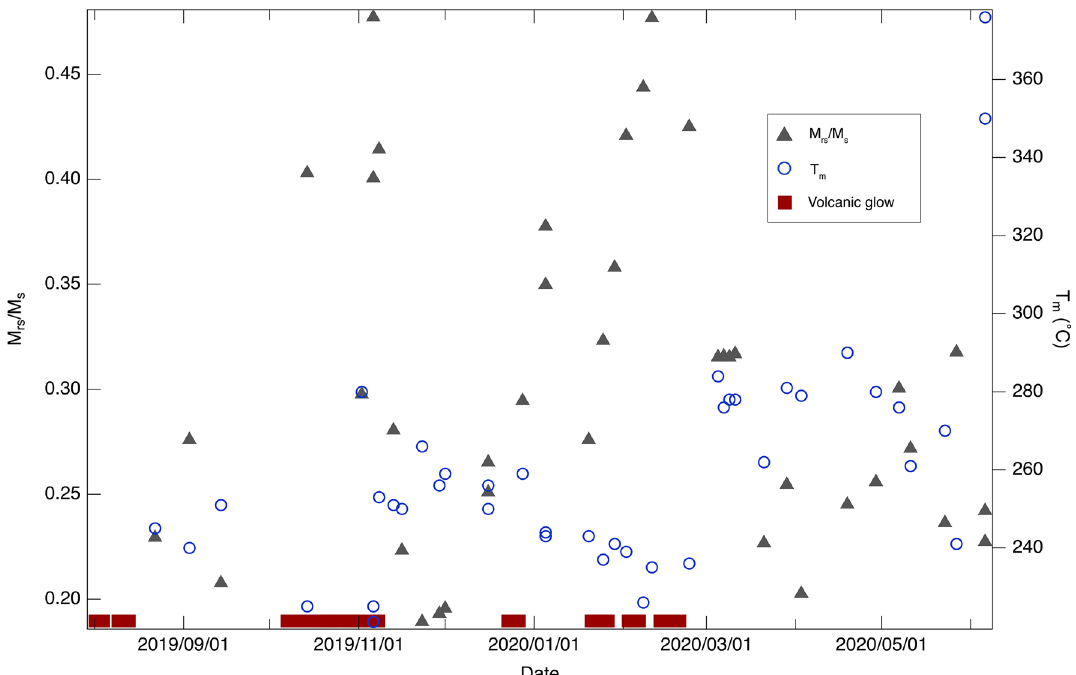
Fig. 4 Hysteresis parameters (M rs /M s ) and the median destructive temperature from the thermomagnetic curve. T m is the temperature given by M s (T m ) 0.5 M s0 , where M s (T) is the saturation magnetization M s at temperature T and M s0 is the M s value at room temperature. Gray triangles = denote M rs /M s and blue circles indicate T m . Red squares indicate the day when the volcanic glow was observed. High M rs /M s values indicate the predominance of SD grains. Low